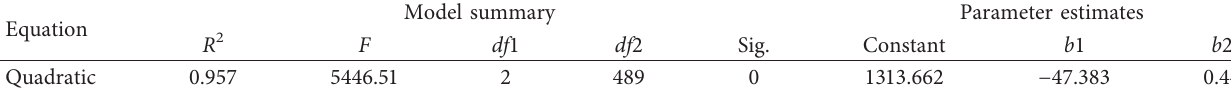
Table 4: Model summary and parameter estimates for quadratic regression.